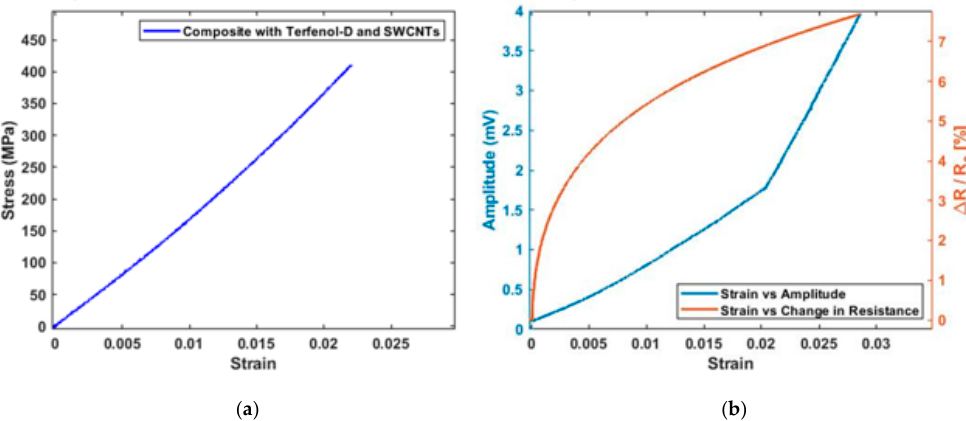
Figure 15. SWCNT/Terfenol-D composites: ( a ) stress–strain response; ( b ) amplitude response and change in electrical resistance.